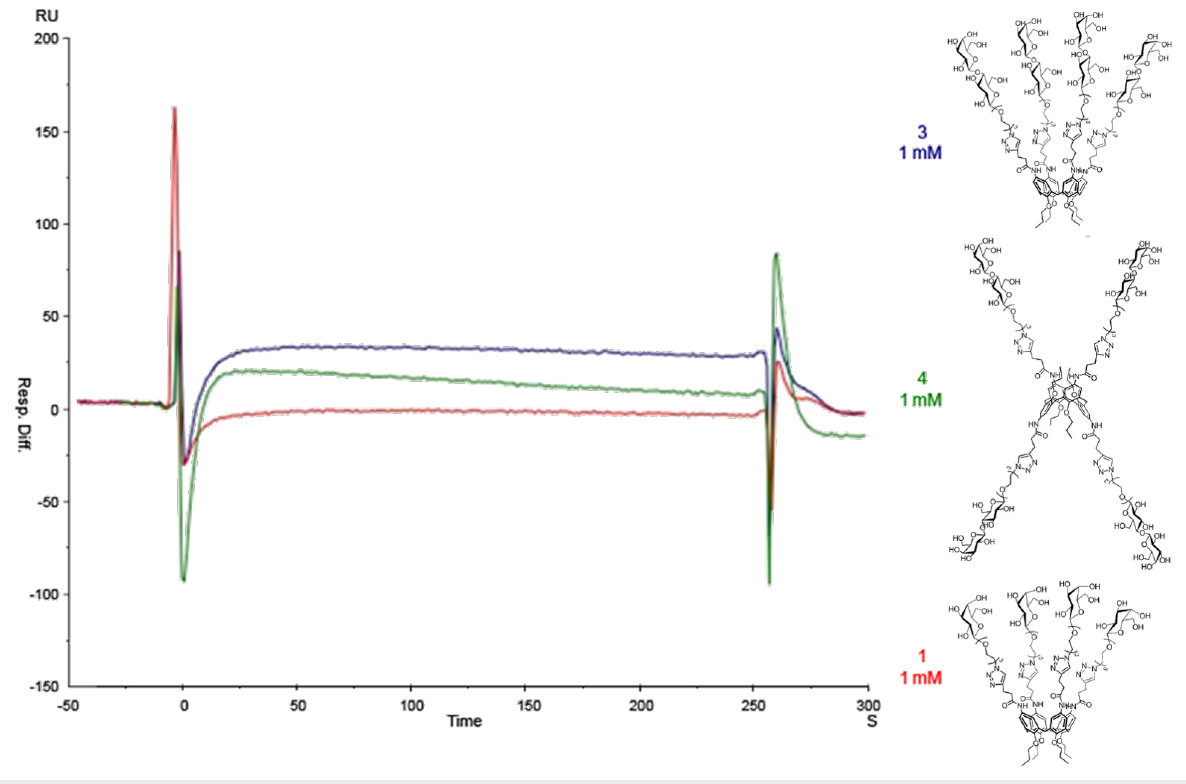
Figure 3: SPR sensorgrams of binding experiment between immobilized Gal-3 and glycocalixarenes 1 , 3 and 4 .